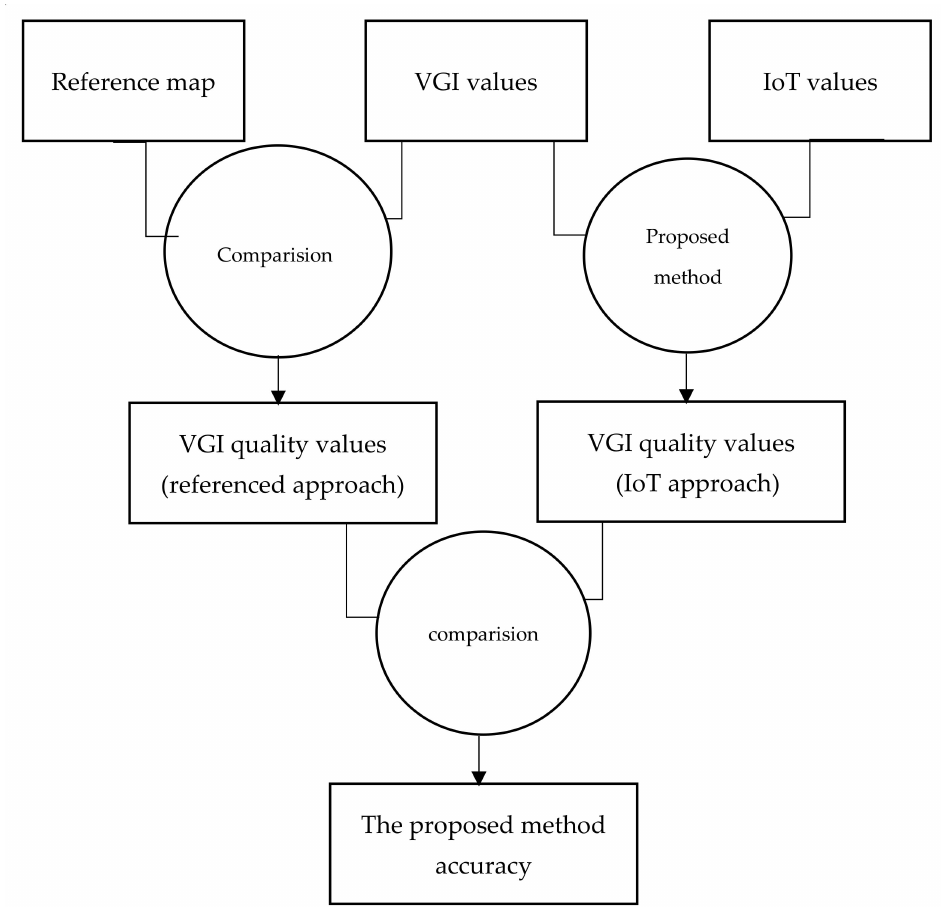
Figure 8. Evaluation flowchart.